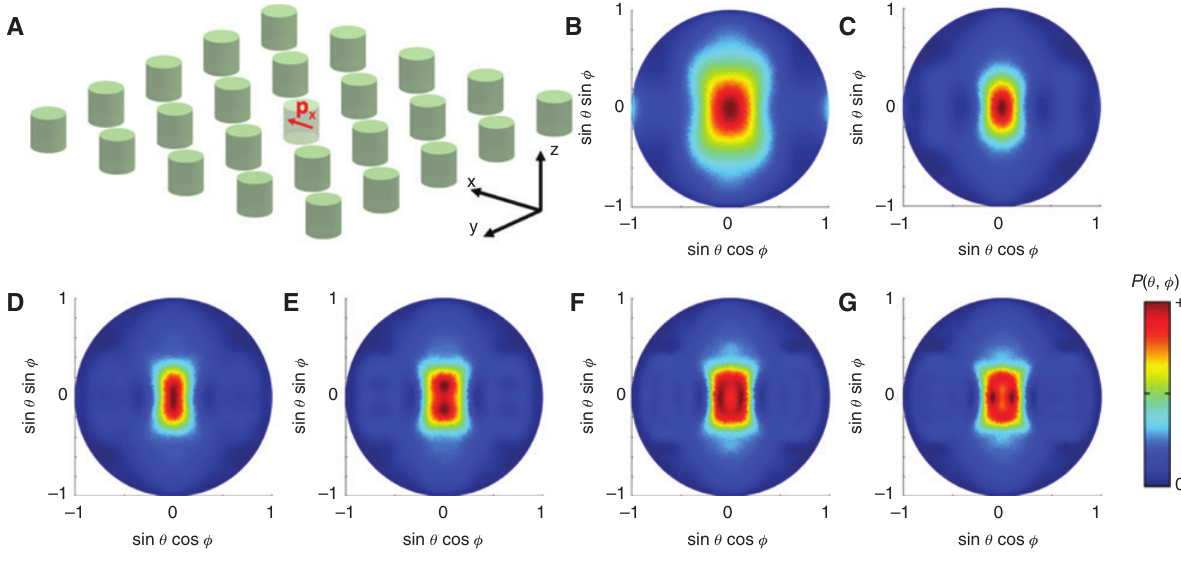
Figure 7: Finite array simulations. (A) Finite array consisting of 5 × 5 dielectic nanocylinders and excited by the point electric dipole p the center of the central nanocylinder. Emission pattern P ( θ , φ ) in the upper semisphere ( z > 0) from a finite array consisting of (B) 3 × 3 unit